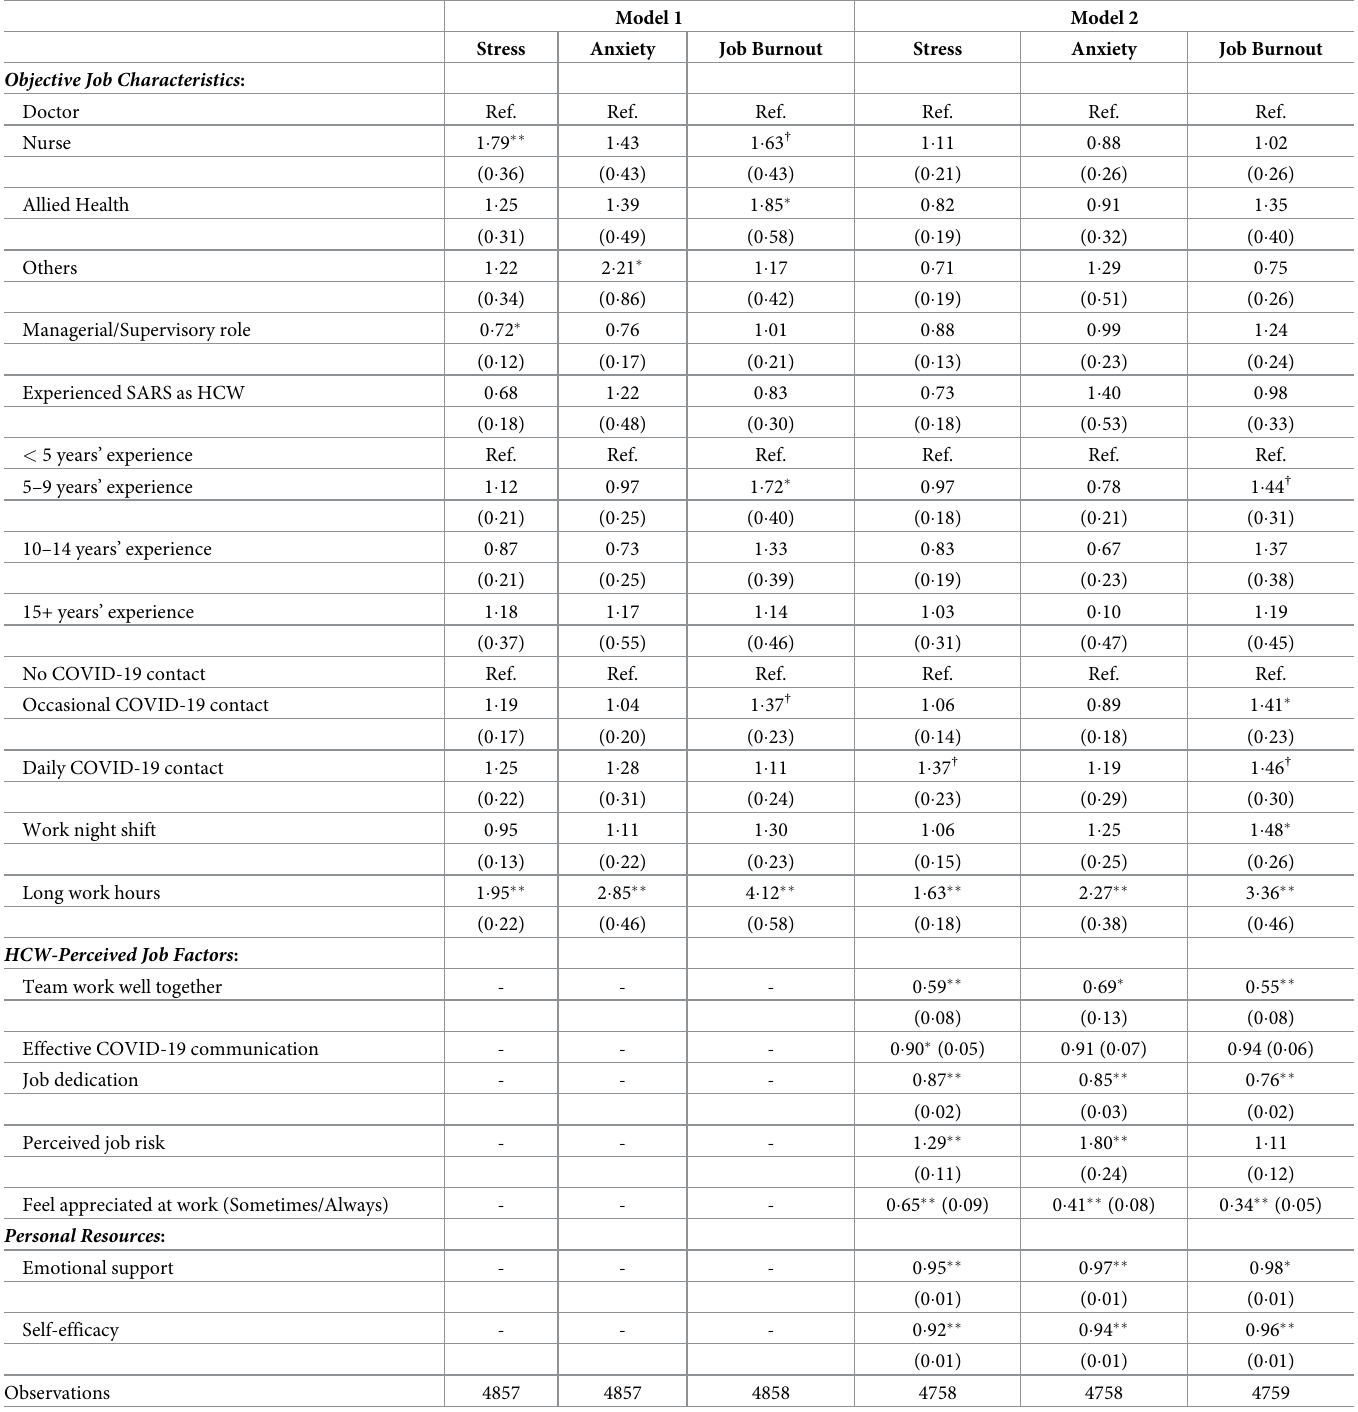
Table 3. Predictors of stress, anxiety, and job